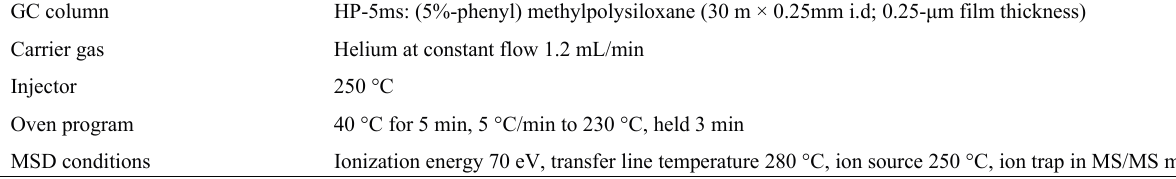
Table 6. GC/MS conditions used for simultaneous analysis of o -AAP, MA and 3-alkyl-2- methoxypyrazines in grape juice [73]. MW: molecular